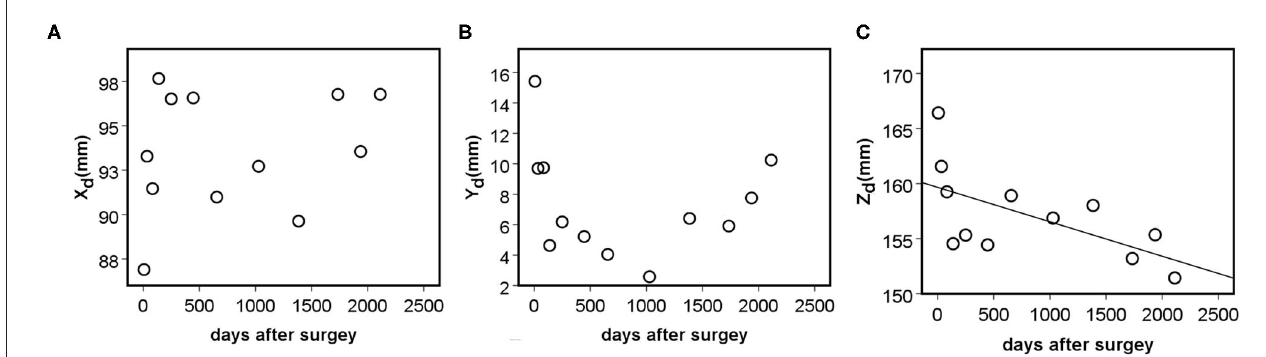
FIGURE 7 | Association between the distance of the mobile (L2 right pedicle screw tip) point from the fixed point (left, caudal trans iliac screw tip) in the anatomical planes, and the number of days after surgery (DAS). (A) Non-significant positive, moderate correlation was found between the X d (frontal plane) and DAS ( ρ = 0.336, p = 0.286). (B) Non-significant, negative, weak correlation was found between the Y d (axial plane) and DAS ( ρ = − 0.182, p = 0.572). (C) Significant, negative, and strong correlation was found between the Z d (sagittal plane) and the number of days after surgery ( ρ = − 0.664, p = 0.018).